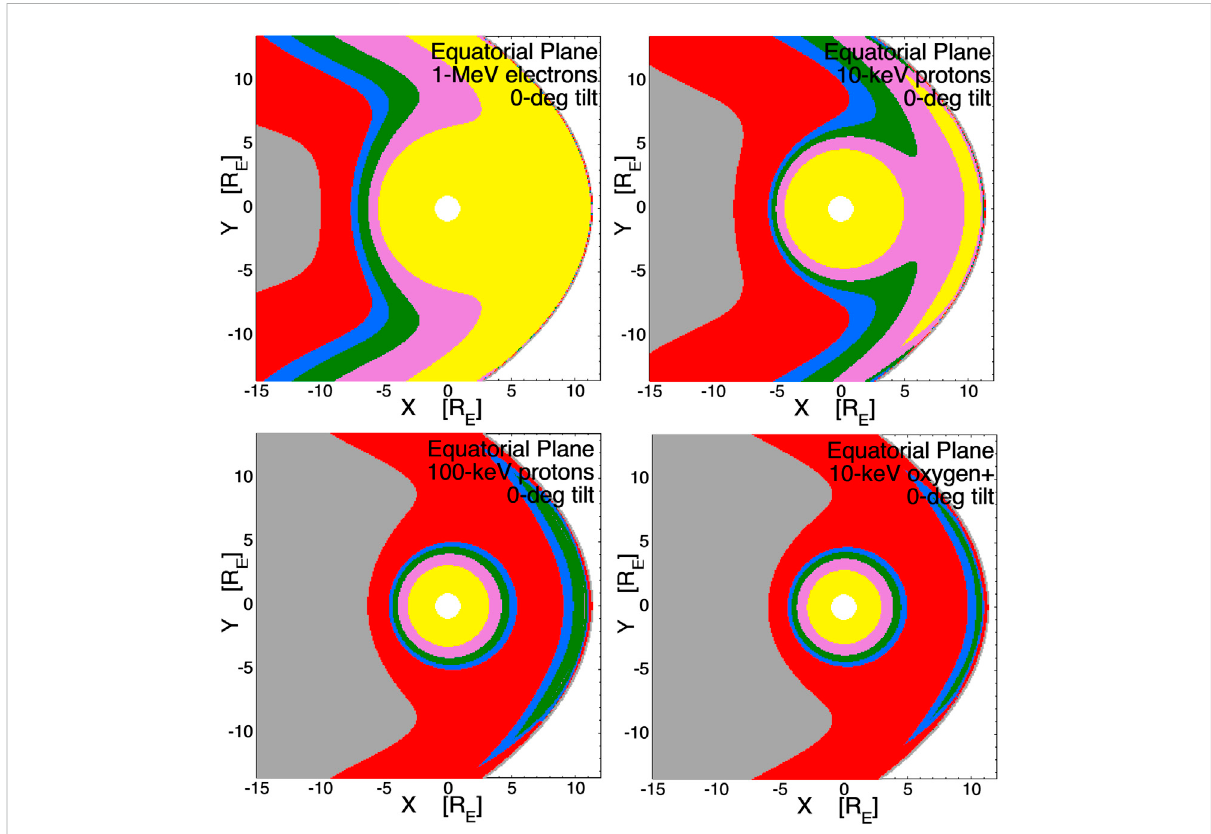
FIGURE 6 Loss-cone-shift maps in the equatorial plane using the T96 magnetc- fi eld model with no dipole tilt. The upper-left is for 1-MeV electrons, the upper right is for 10-keV protons, the lower-left is for 200-keV protons, and the lower-right is for 10-kV oxygen O + . The color scheme is yellow (shift < 0.5 ° ), pink (shift 0.5 ° – 1 ° ), green (shift 1 ° – 1.5 ° ), blue (shift 1.5 ° – 2 ° ), red (shift 2 ° – 10 ° ), and gray (shift > 10 °